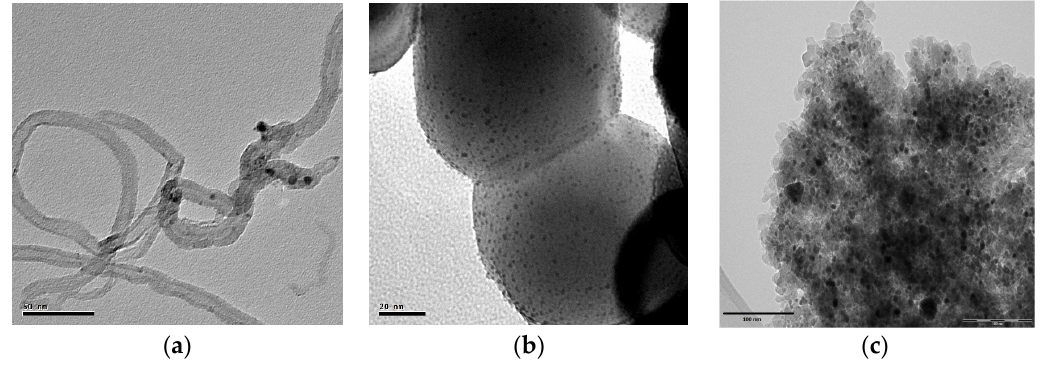
Figure 1. TEM (transmission electron microscopy) ages of: ( a ) Ru/CNT; ( b ) Ru/TiO 2 ; and ( c ) Ru/Beta ‐ 12.5.